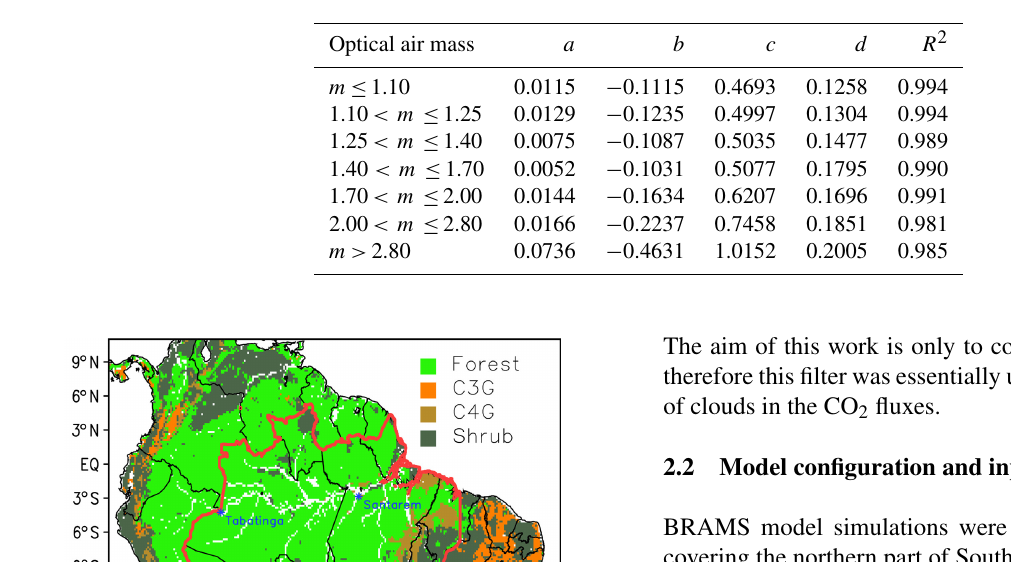
Table 1. Parameters for a third-degree polynomial fit to the diffuse fraction of broadband solar irradiance reaching the surface as a function of AOD at 670nm for distinct air mass intervals.